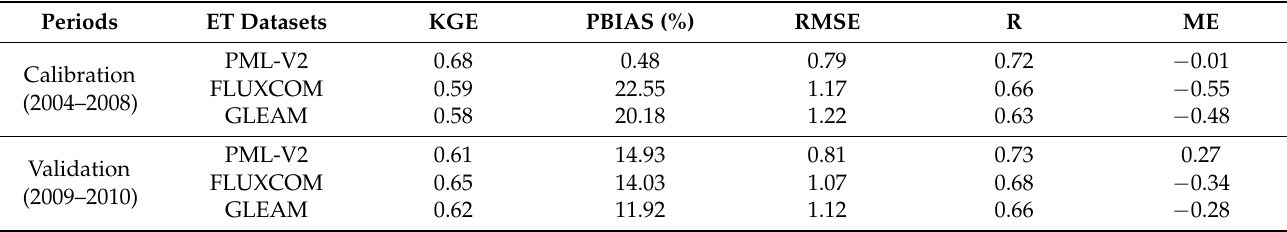
Table 3. Evaluation indices of ET simulation based on Scheme